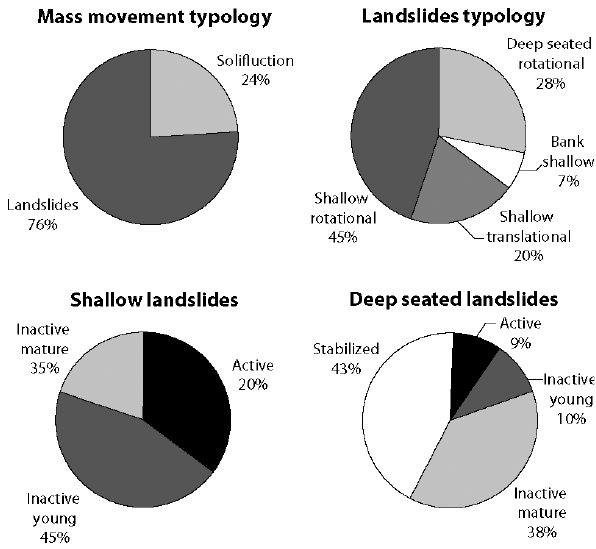
Fig. 2. Observed mass movement characteristics and states of activ- ity of the detailed geomorphological landslide inventory.